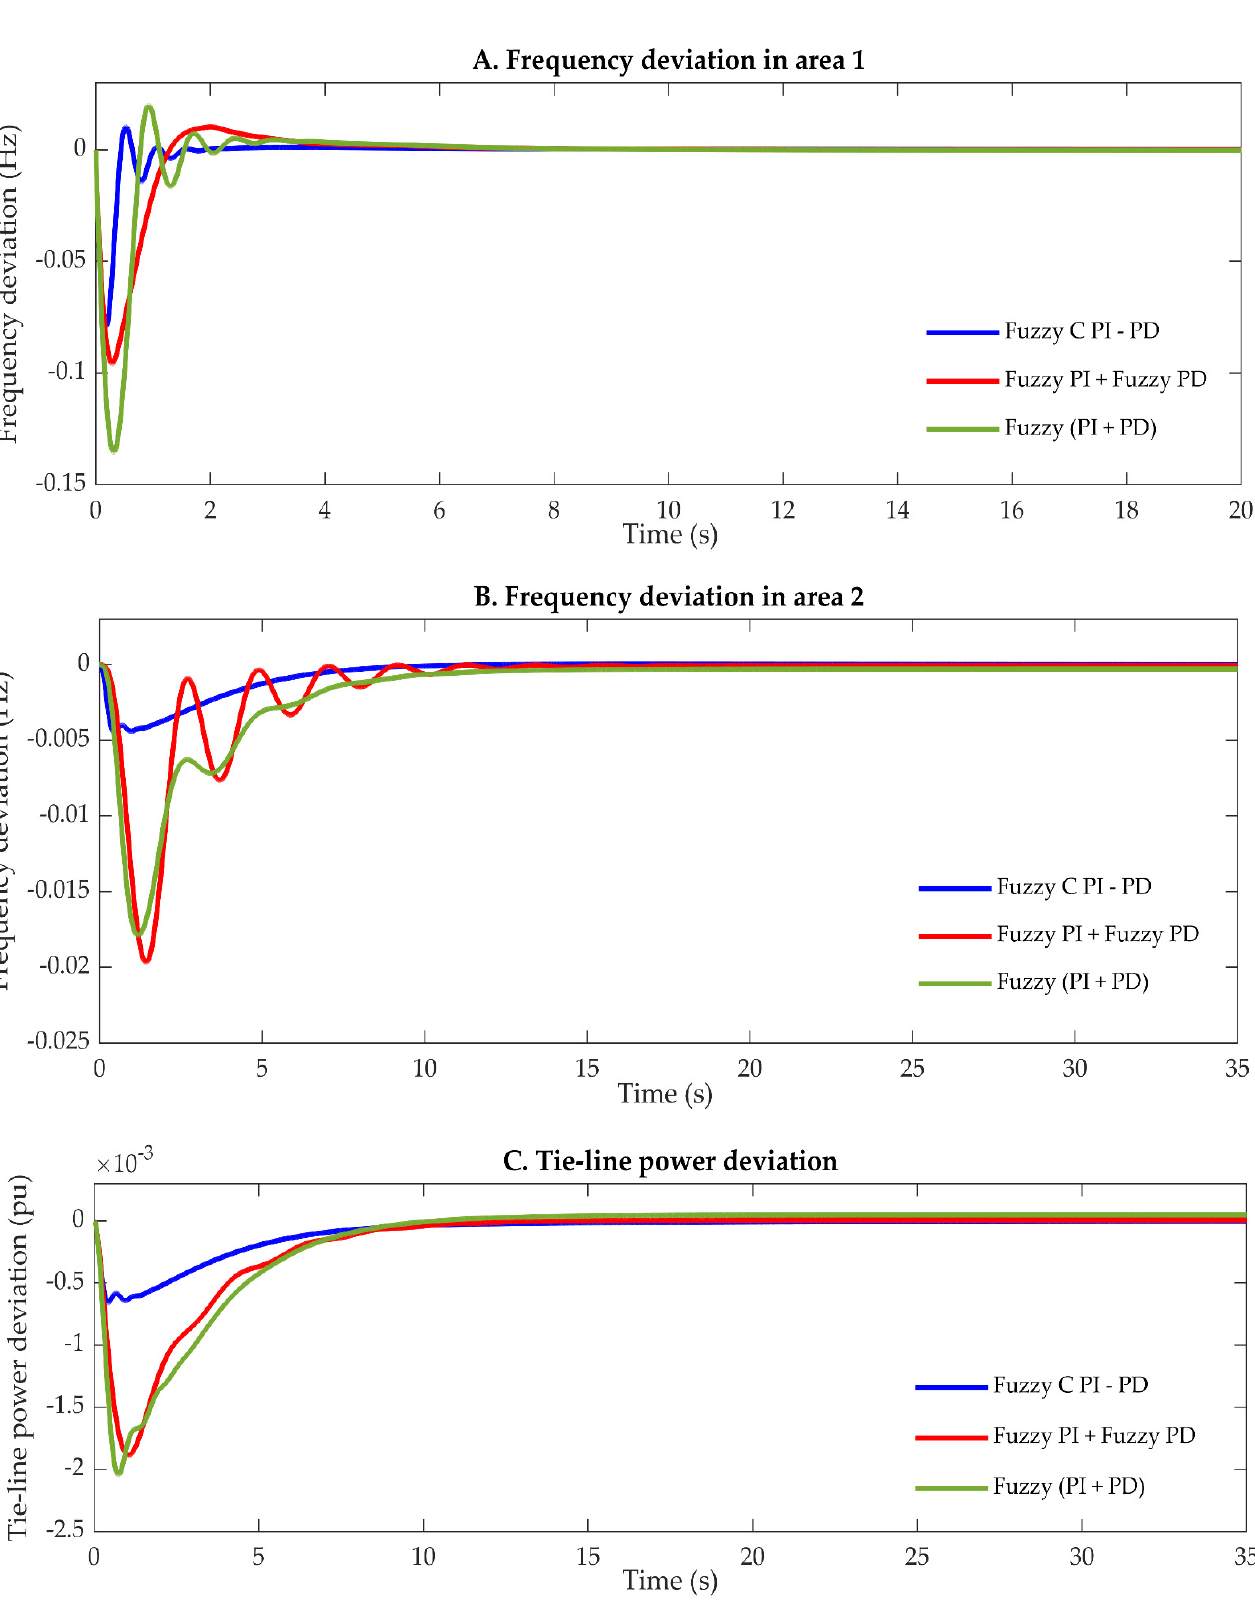
Figure 34. Dynamic response of the testbed power system based on different fuzzy controllers under parametric uncertainty conditions, case 13. ( A ) Frequency variation in area 1; ( B ) frequency variation in area 2; ( C ) tie-line power variation.